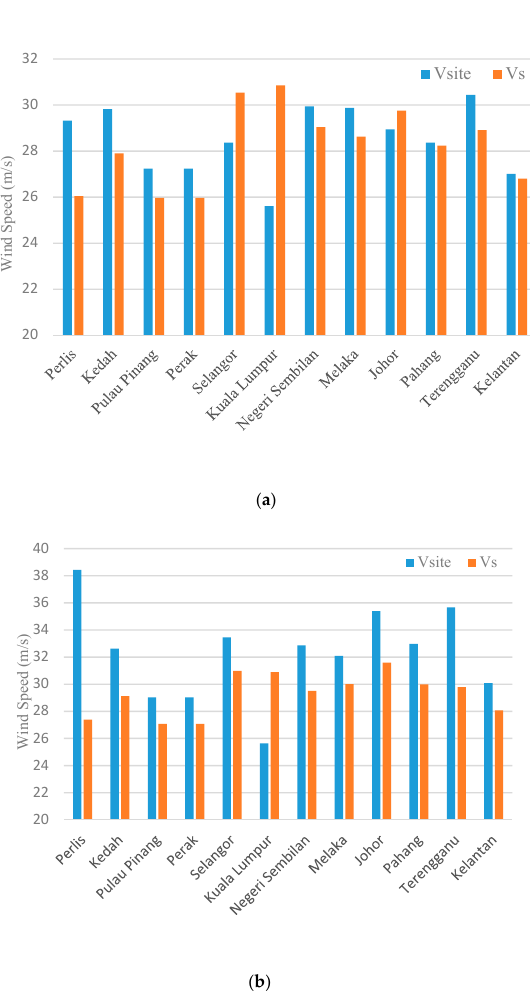
Figure 13. A comparison between wind speeds ( V s and V site ): ( a ) The mean; ( b ) the maximum.